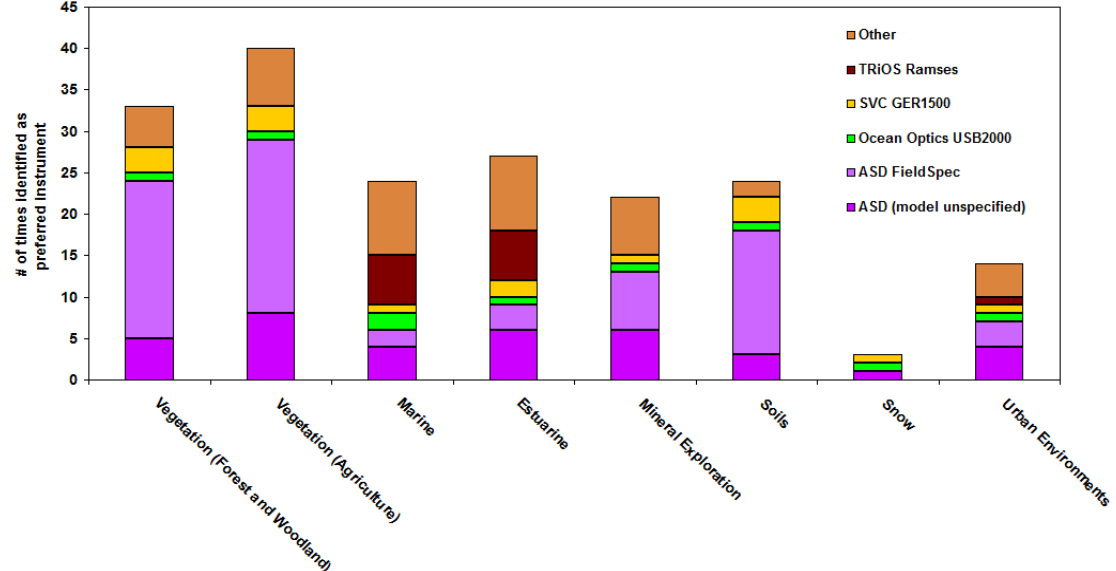
Figure 4. Field spectroscopy instrument preference by expert